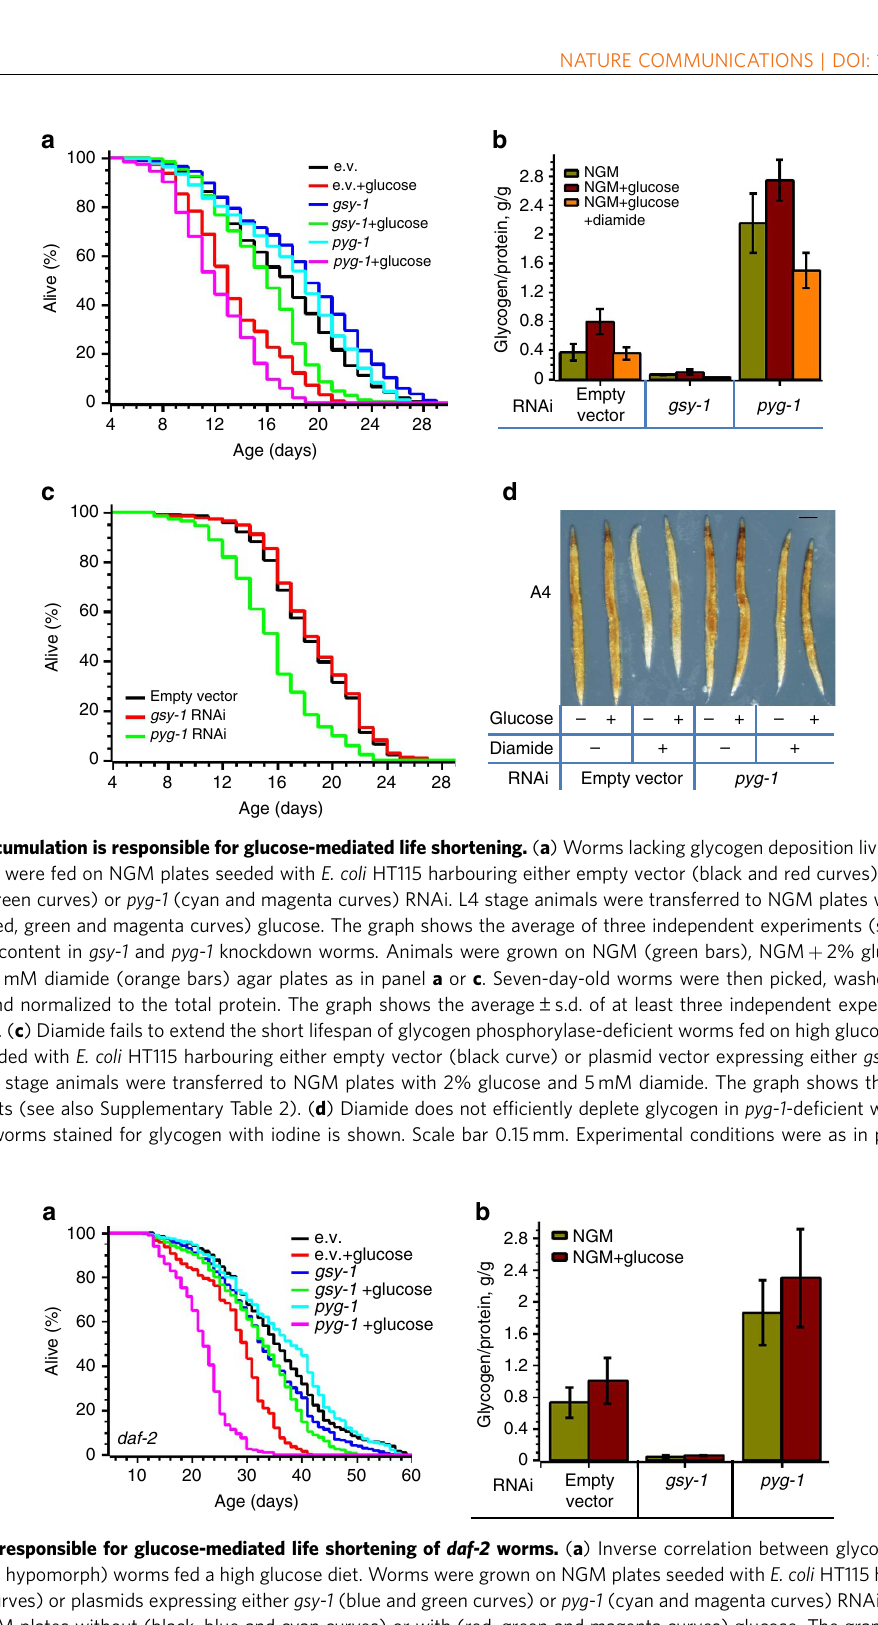
Figure 7 | Glycogen is responsible for glucose-mediated life shortening of daf-2 worms. ( a ) Inverse correlation between glycogen production and lifespan of daf-2 (e1370, hypomorph) worms fed a high glucose diet. Worms were grown on NGM plates seeded with E. coli HT115 harbouring either empty vector (black and red curves) or plasmids expressing either gsy-1 (blue and green curves) or pyg-1 (cyan and magenta curves) RNAi. L4 stage animals were then transferred on NGM plates without (black, blue and cyan curves) or with (red, green and magenta curves) glucose. The graph shows the average of three independent experiments (see also Supplementary Table 2). ( b ) Glycogen content in daf-2 worms depleted of gsy-1 or pyg-1 . Worms were grown as in panel a on NGM (green bars) or NGM þ 2% glucose (red bars) plates. Seven-day-old worms were picked, washed and the amount of glycogen determined and normalized to the total protein. The graph shows the average ± s.d. of at least three independent experiments (see also Supplementary Table 3). consistently, increases the lifespan of wt, daf-2 and daf-16 worms fed glucose, DAF-2 signalling could still suppress DAF-16; fed a high glucose diet (Figs 6a,7a and 8). The latter indicates however, this effect is countered by low glycogen, which relieves that glycogen and daf-16 are parallel signalling pathways the AMPK inhibition (Fig. 8d), thereby promoting daf-16 independently controlling the lifespan. In GSY-1-deficient worms activation 49 . NATURE COMMUNICATIONS|8:15868|DOI: